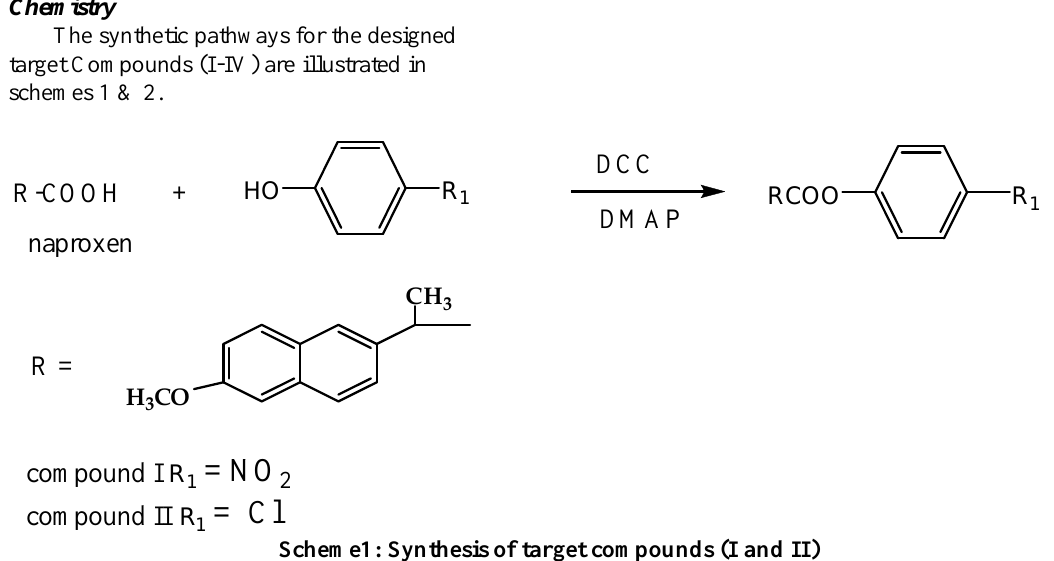
Scheme1: Synthesis of target compounds (I and II)